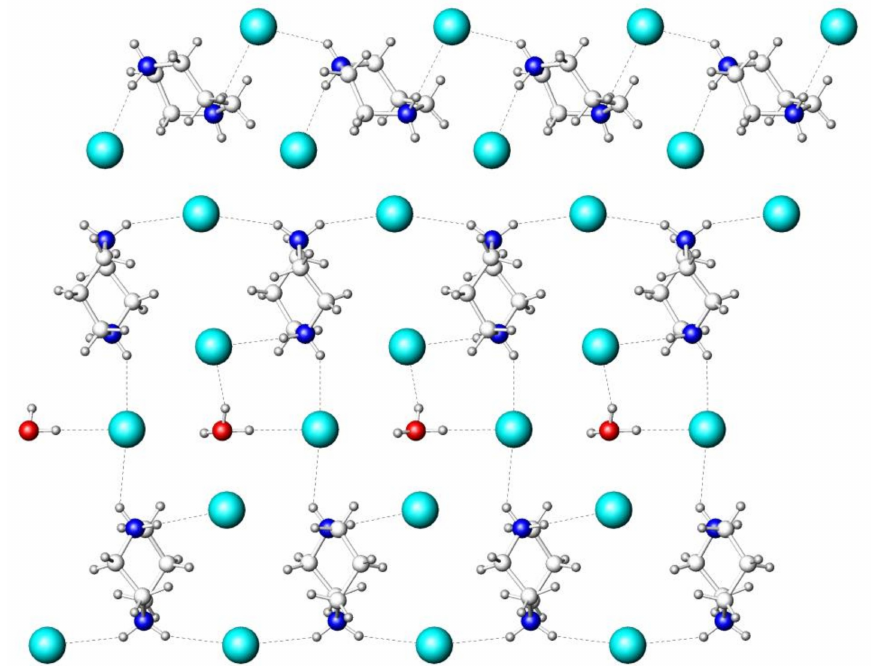
Figure 5. Pattern of hydrogen bonds in the crystal structure of (HpipeH 2 ) 3 (H 3 O)I 7 involving HpipeH 22 + and H 3 O + cations and iodide anions. Two strands running along the c axis are shown. Iodine, cyan; oxygen, red; nitrogen, blue; carbon, light gray, hydrogen, dark gray. Hydrogen (N)H ··· O and (N)H ··· I bonds are shown as dashed